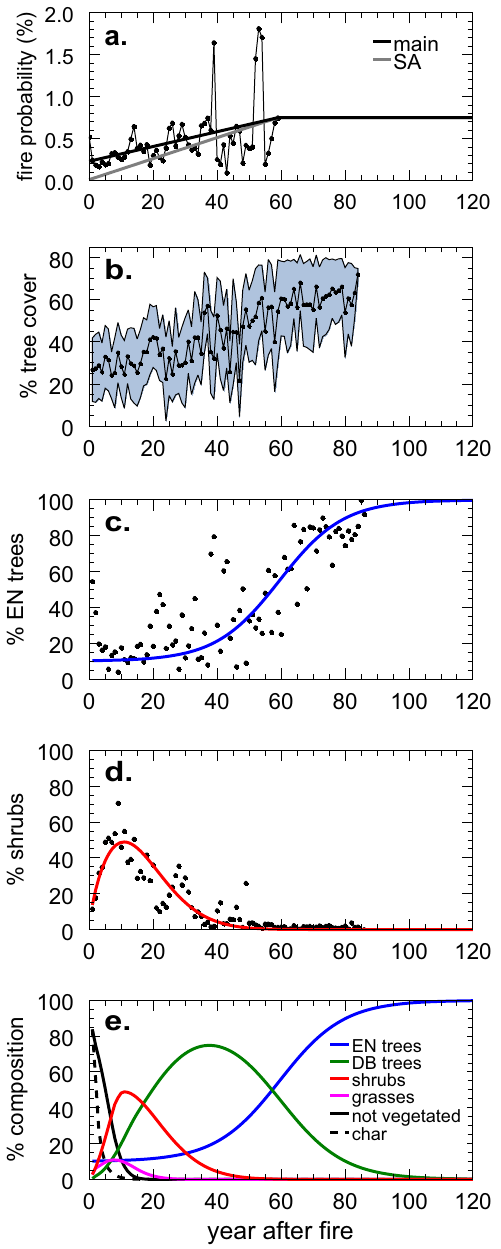
Fig. 2. Post-fire trajectories of burn probability (a) , tree cover (b) , evergreen needleleaf (EN) trees (c) , shrubs (d) , and generalized veg- etation succession (e) . In (a) , a regression line was fit to annual probabilities of re-burn for 0–60yr from the Canadian National Fire Database and the Alaskan Large Fire Databases (NFDBs). The sen- sitivity analysis (“SA”) line was forced through (0,0) and used in the “nonflammable young stands” sensitivity analysis. (b–d) were developed using MODIS vegetation continuous fields (MOD44B) and land cover (MCD12Q1) over fire scars from the NFDBs. The shaded area in (b) represents ± 1 standard error. A logistic curve was fit to EN trees, and a Weibull curve to shrubs. DB = “deciduous broadleaf”. The char type in (e) is included as part of the non- vegetated